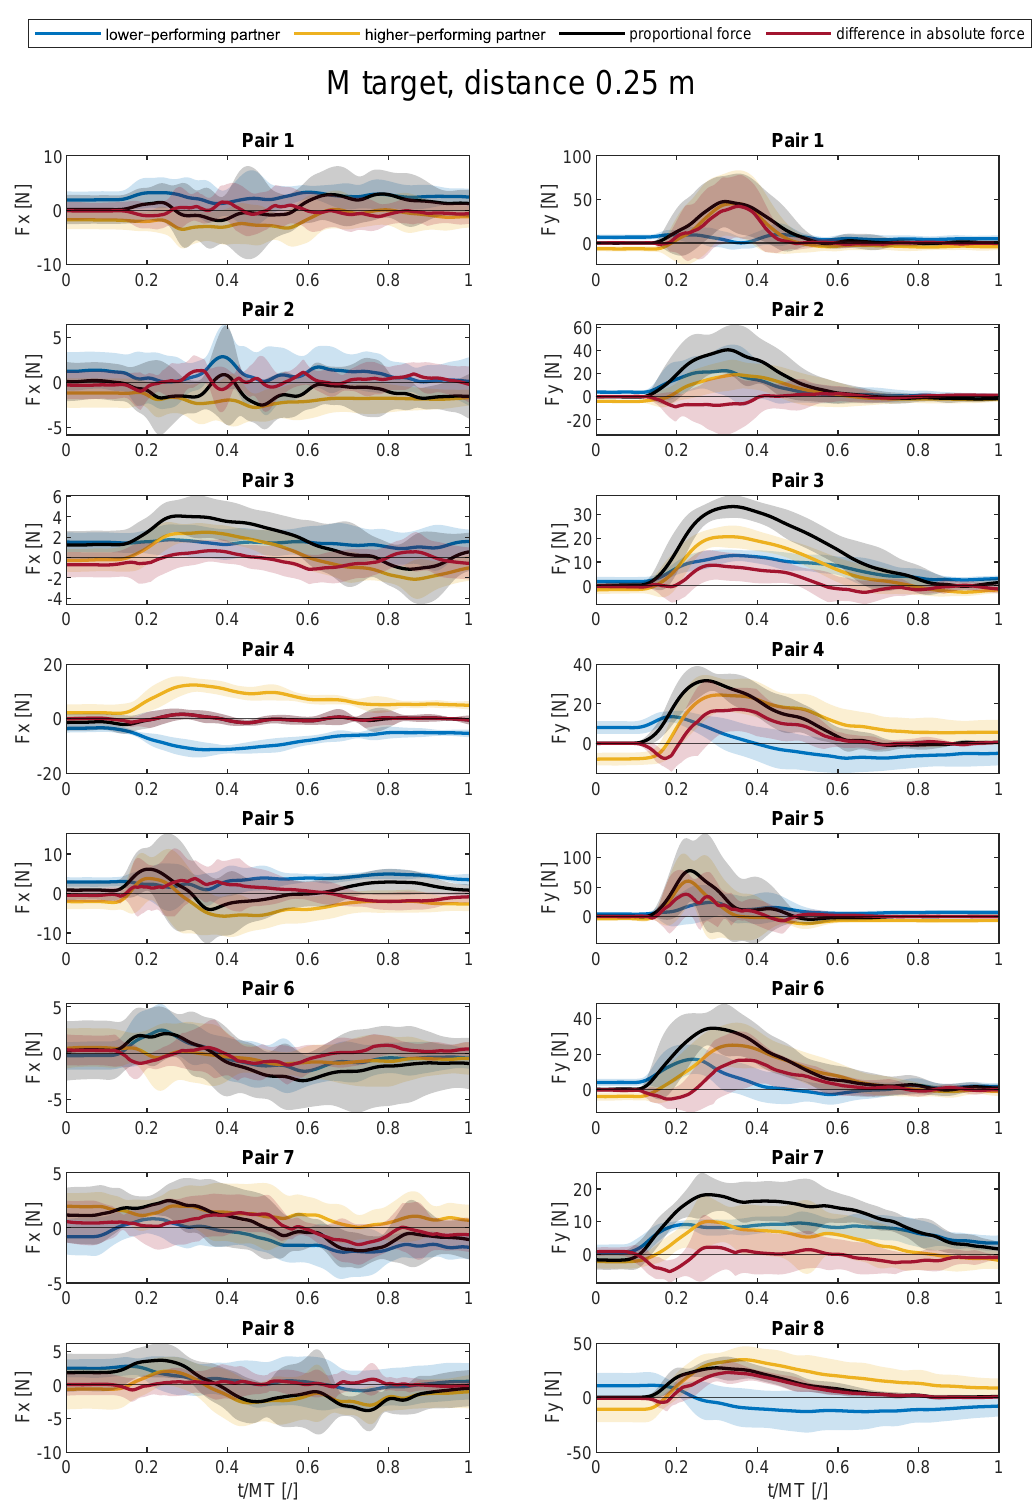
Figure A6. Average force trajectories with standard deviation (shaded area) in x- and y-direction in collaborative task for the medium target at the distance of 0.25